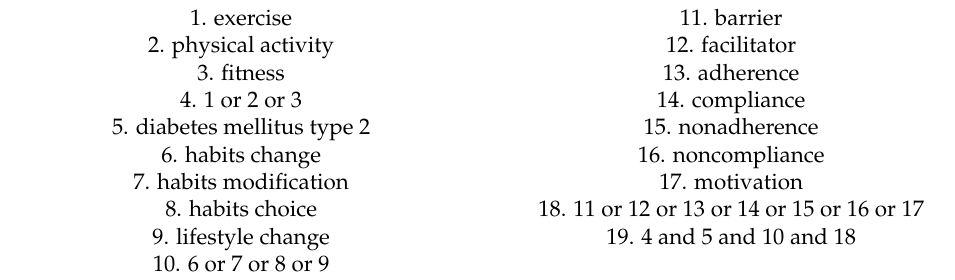
Table 1. Database search